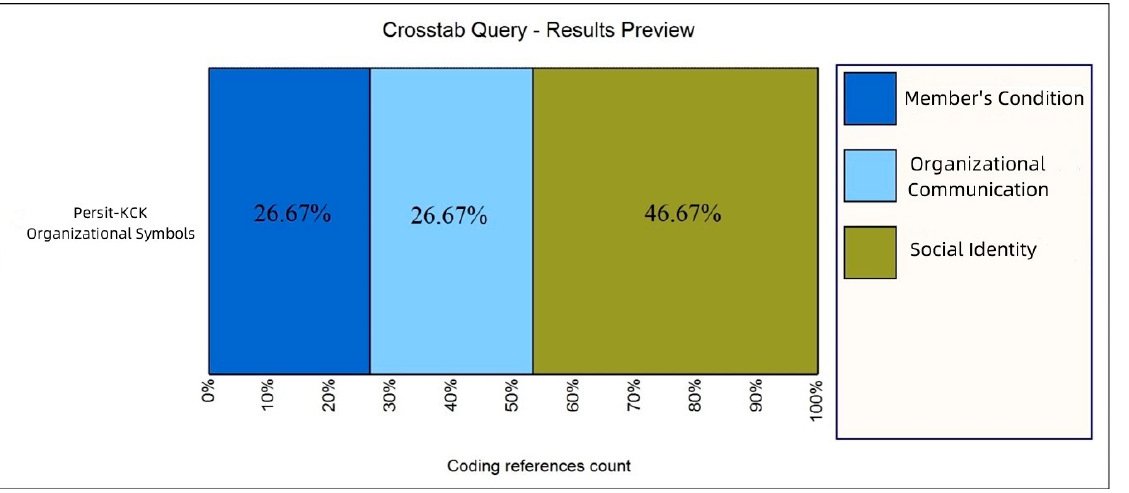
Figure 6. Analysis of the influence of Persit-KCK organizational symbols on social identity and organizational communication. Source: processed from Nvivo 12 Pro , 2022.